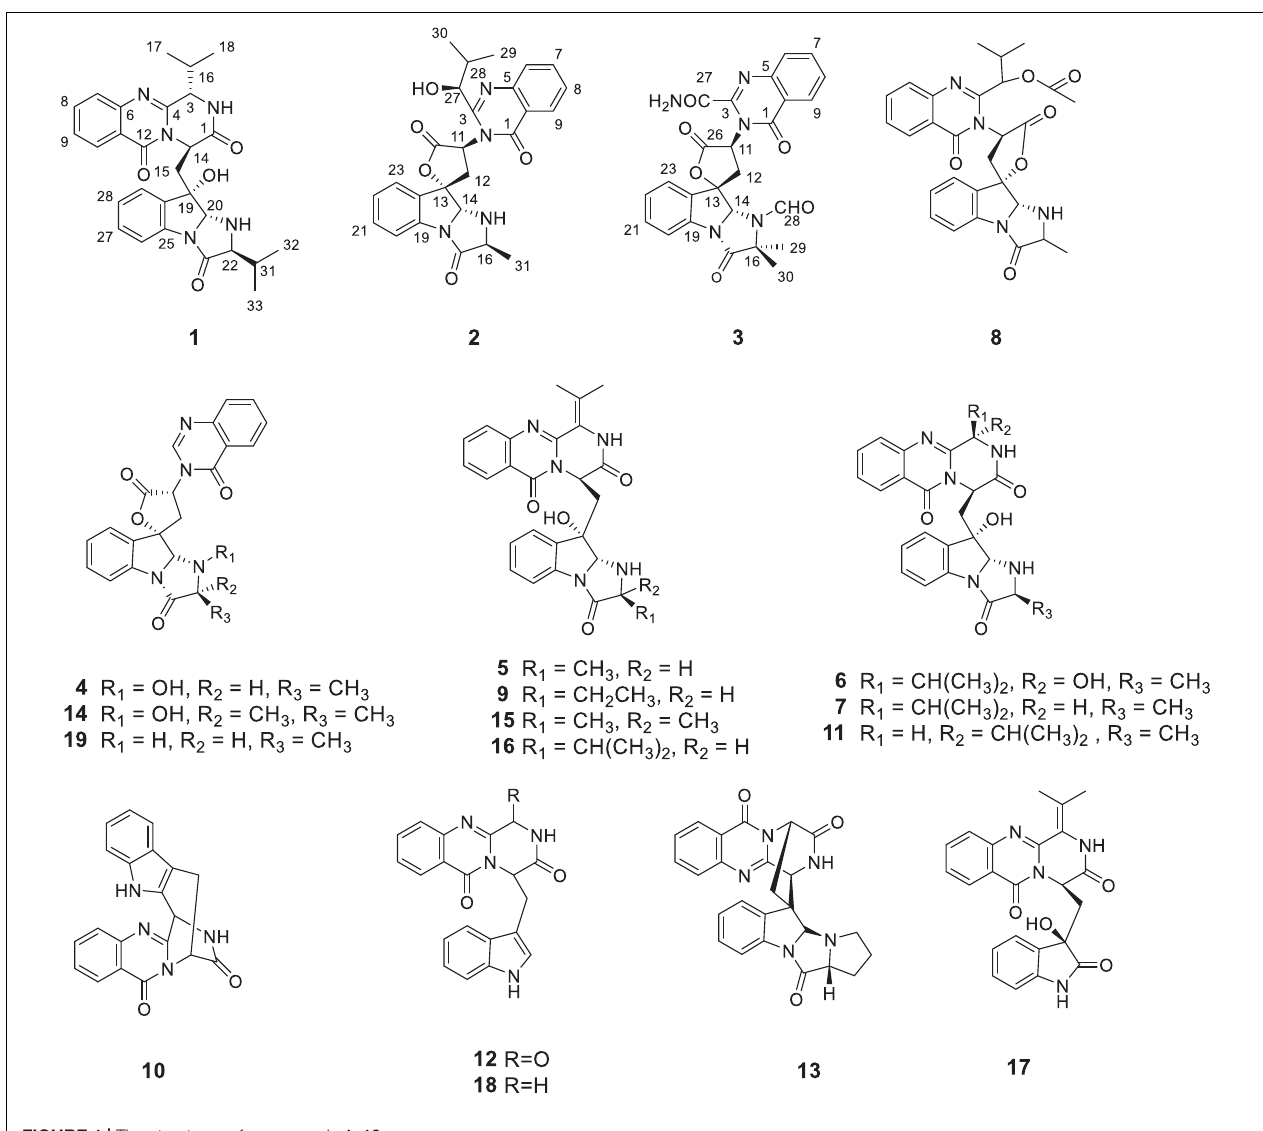
FIGURE 1 | The structures of compounds 1 – 19